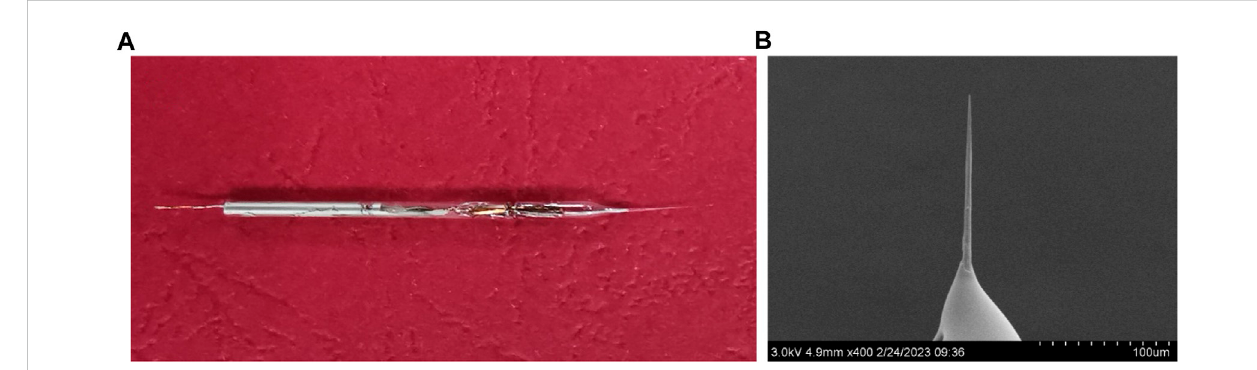
FIGURE 1 (A) Photograph of the CF μ E and (B) scanning electron microscopy picture of the CF μ E